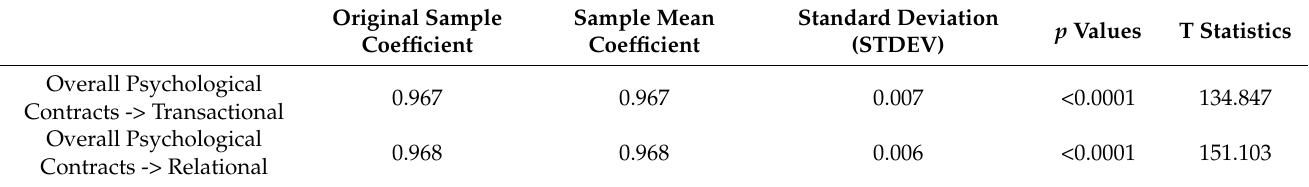
Table 5. Analysis of Structural Model Path Coefficients (Mean, STDEV, T-Values).